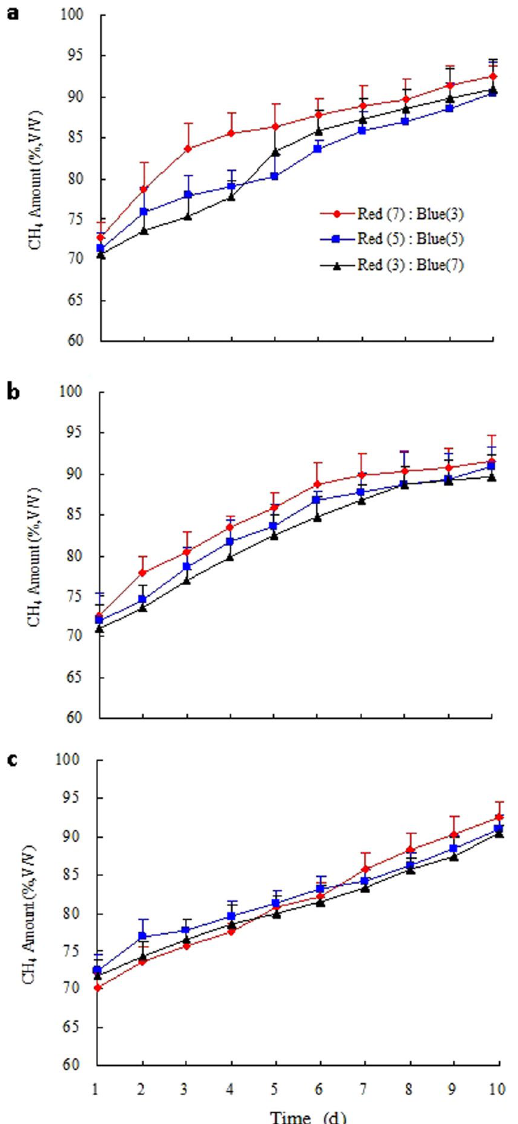
Figure 4. The CH 4 amount (v/v) of biogas over time at cultures 2 under the mixed LED light wavelength treatments for the three selected microalgae species: ( a ) Chlorella vulgaris , ( b ) Scenedesmus obliquus , and ( c ) Nitzschia palea